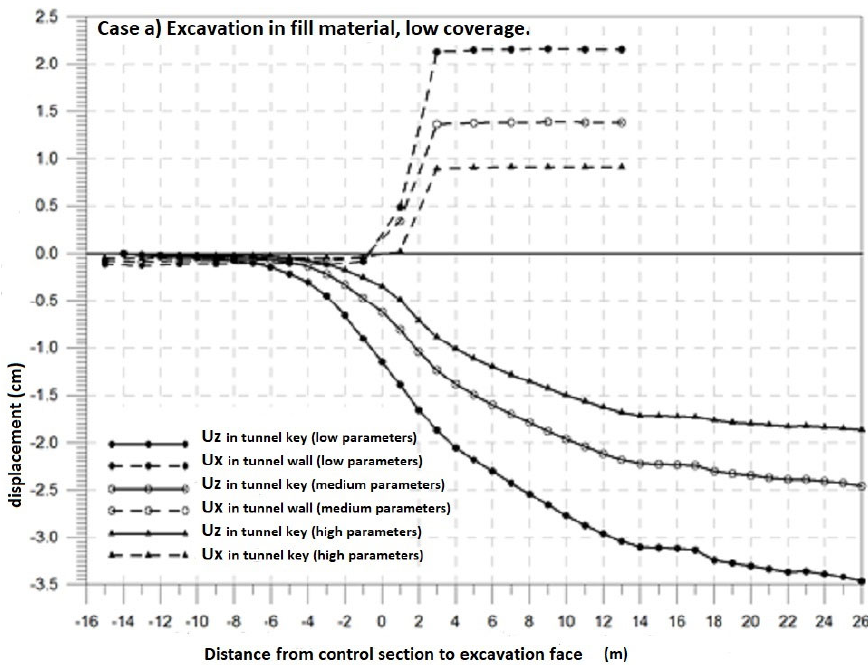
Figure 15. Evolution of the displacements in code (Uz) and gable (Ux) with respect to the distance to the front of the excavation in a control section in case (a).